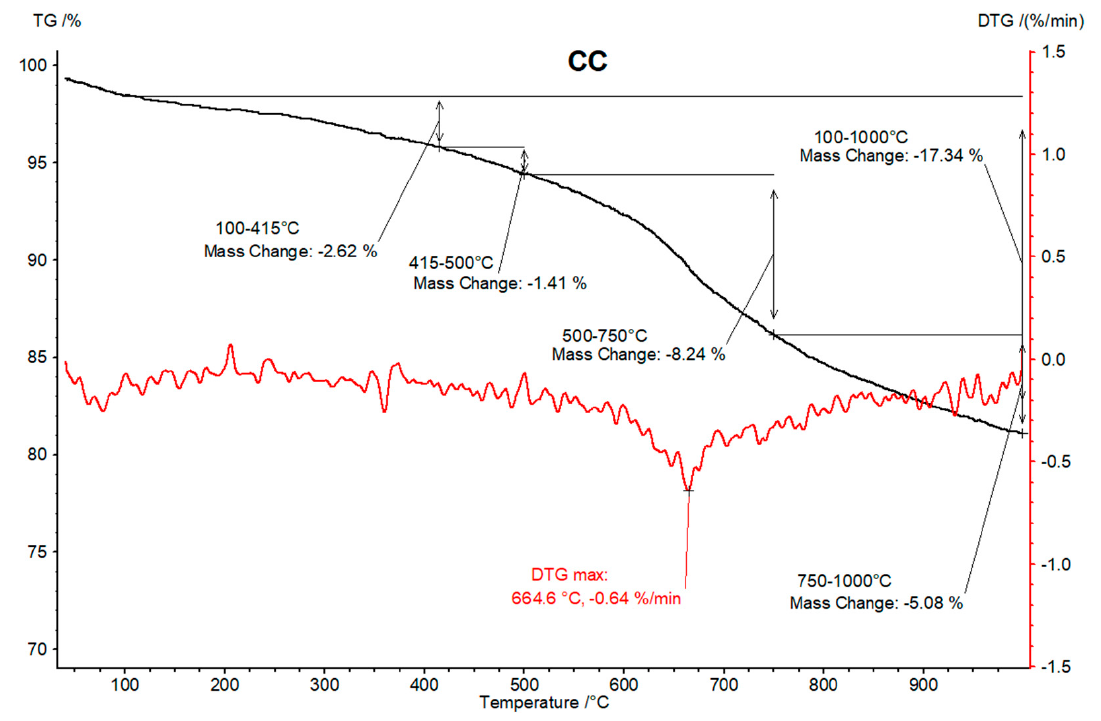
Figure A6. TG/DTG curves obtained for commercial charcoal.